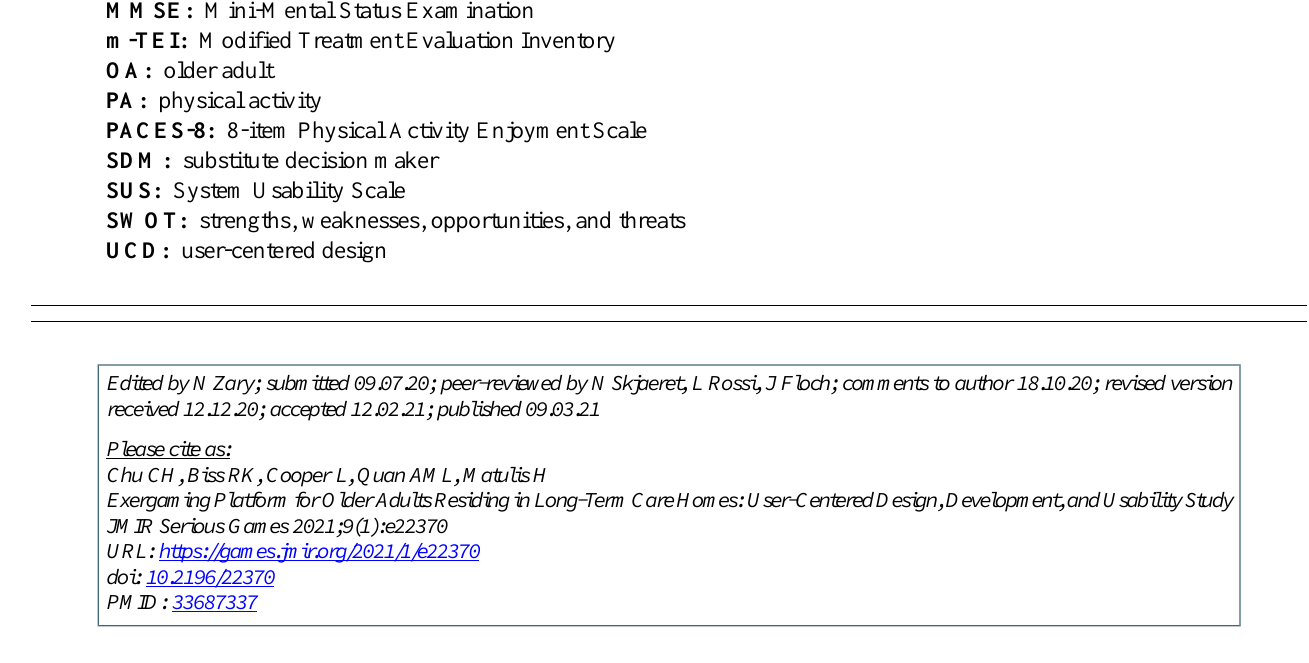
AGE-WELL NCE: Aging Gracefully Across Environments Using Technology to Support Wellness, Engagement and Long Life Networks of Centers